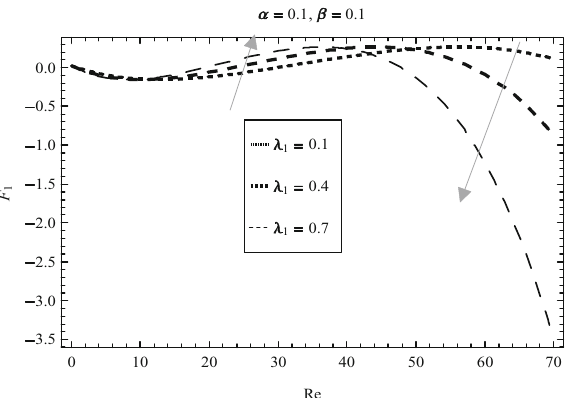
Fig. 19 Variation of F 1 along Re for different values of λ 1 skin friction along the main flow direction and skin friction is exerted by the plate on the fluid. On the contrary, for small values of Reynolds number the inertial forces become dominant over the viscous forces resulting the change in the direction of the skin friction, that is, the skin friction is exerted by the fluid on the plate which enhances by increasing the Reynolds number. Figs. 21, 22 and 23 are drawn for skin friction component along z -direction versus the Reynolds number for different values of injection/suction parameter, the Deborah number and the ratio of relaxation time to the retardation time, respectively. The magnitude of skin friction component F 2 increases with the increase of injection/suction parameter. The increment in the skin